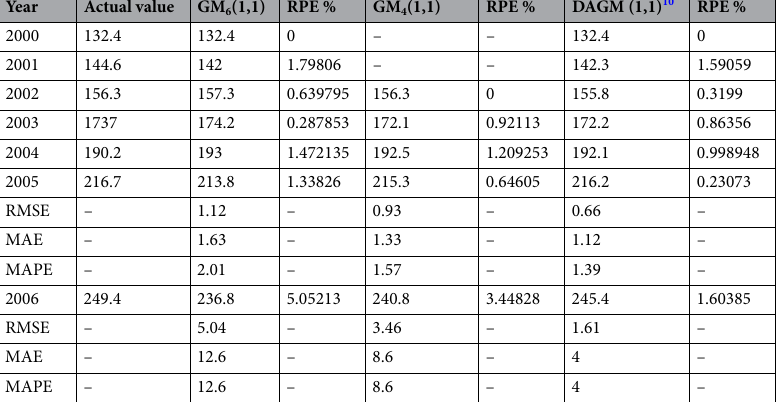
Table 3. Case 2: Forecasting results of different grey models 45